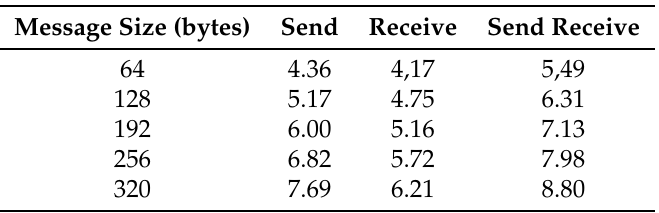
Table 3. Asynchronous IPC primitives latency ( µ